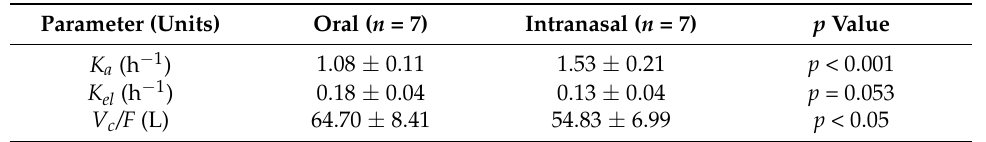
in the central compartment.